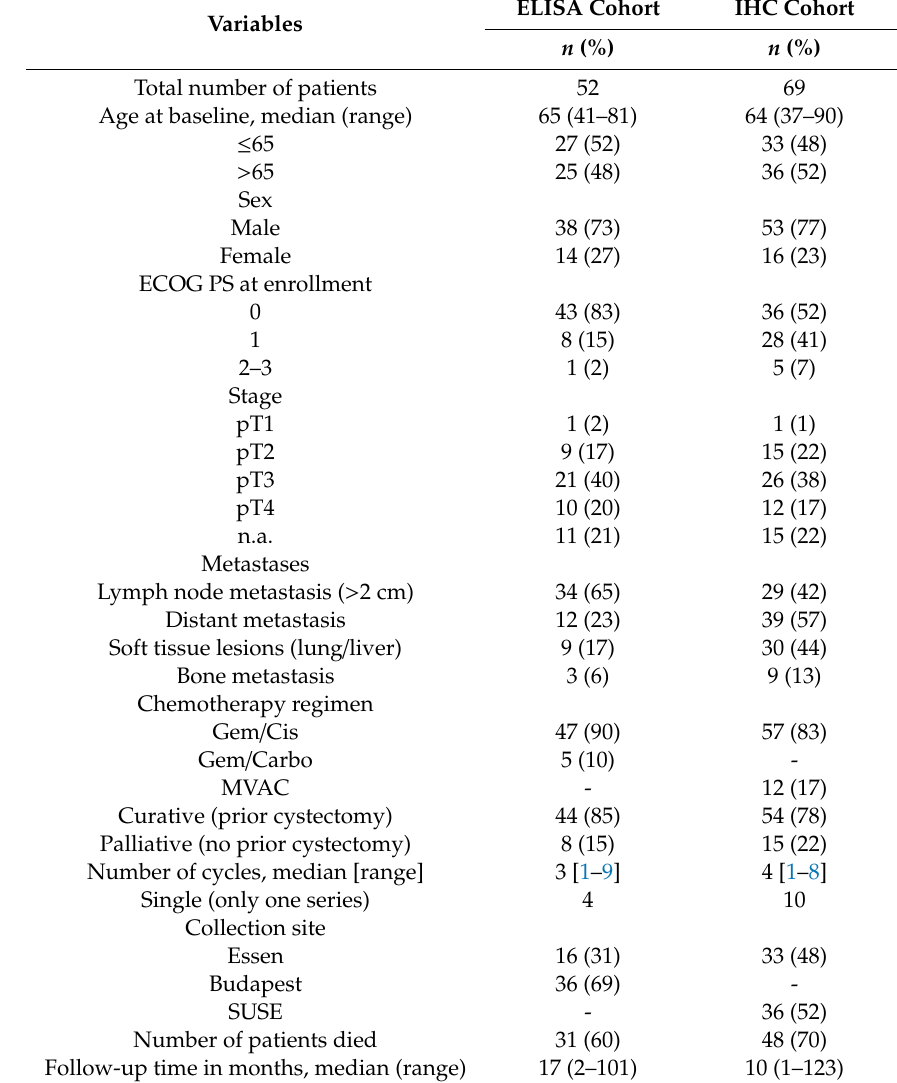
Table 1. Patients’ characteristics. ECOG—Eastern Cooperative Oncology Group, PS—performance status. Gem / Cis—gemcitabine + cisplatin, Gem / Carbo—gemcitabine + carboplatin, MVAC—methotrexate + vinblastine plus + doxorubicin + cisplatin.